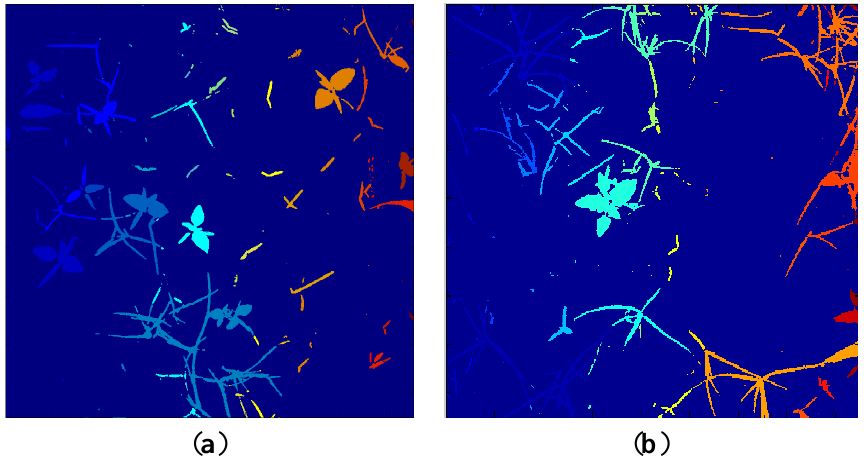
Figure 8. Labelling regions. Each isolated region is identified by a unique